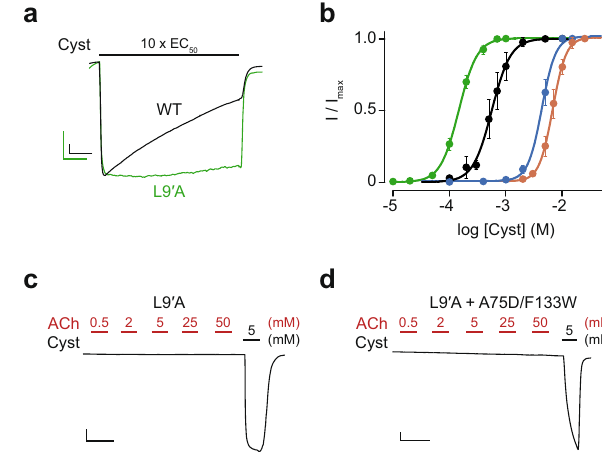
Fig. 6 Rapid desensitization does not explain the inability of ACh to activate ELIC. a Representative whole-cell traces of the L9 ′ A mutant (green) relative to wild-type (WT) ELIC (black). A saturating concentration of cysteamine (10 x EC 50 ) was applied to each oocyte for 6 min ( n = 3 and 4 independent oocytes for WT and L9 ′ A, respectively). Maximum current amplitudes were normalized and overlaid to facilitate qualitative comparison of the macroscopic desensitization rates. b Dose-response curves of cysteamine activated WT ELIC (black), the L9 ′ A mutant (green), the A75D/F133W double mutant (burgundy), and the L9 ′ A + A75D/ F133W triple mutant (blue). A minimum of 6 independent oocyte replicates were performed for each mutant. Error bars represent one standard deviation from the mean. c , d No ACh-induced currents were observed for either c the L9 ′ A mutant or d the L9 ′ A + A75D/F133W triple mutant ELIC upon 30 s applications of increasing concentrations of ACh (0.5 to 50 mM), whereas a 5 mM application of cysteamine led to robust activation in both cases. A total of seven and four independent oocyte replicates were collected for the L9 ′ A and the L9 ′ A + A75D/F133W mutants, respectively. The x - and y -axis of the scale bars in ( a , c , d ) correspond to 1 min and 0.5 µ A,